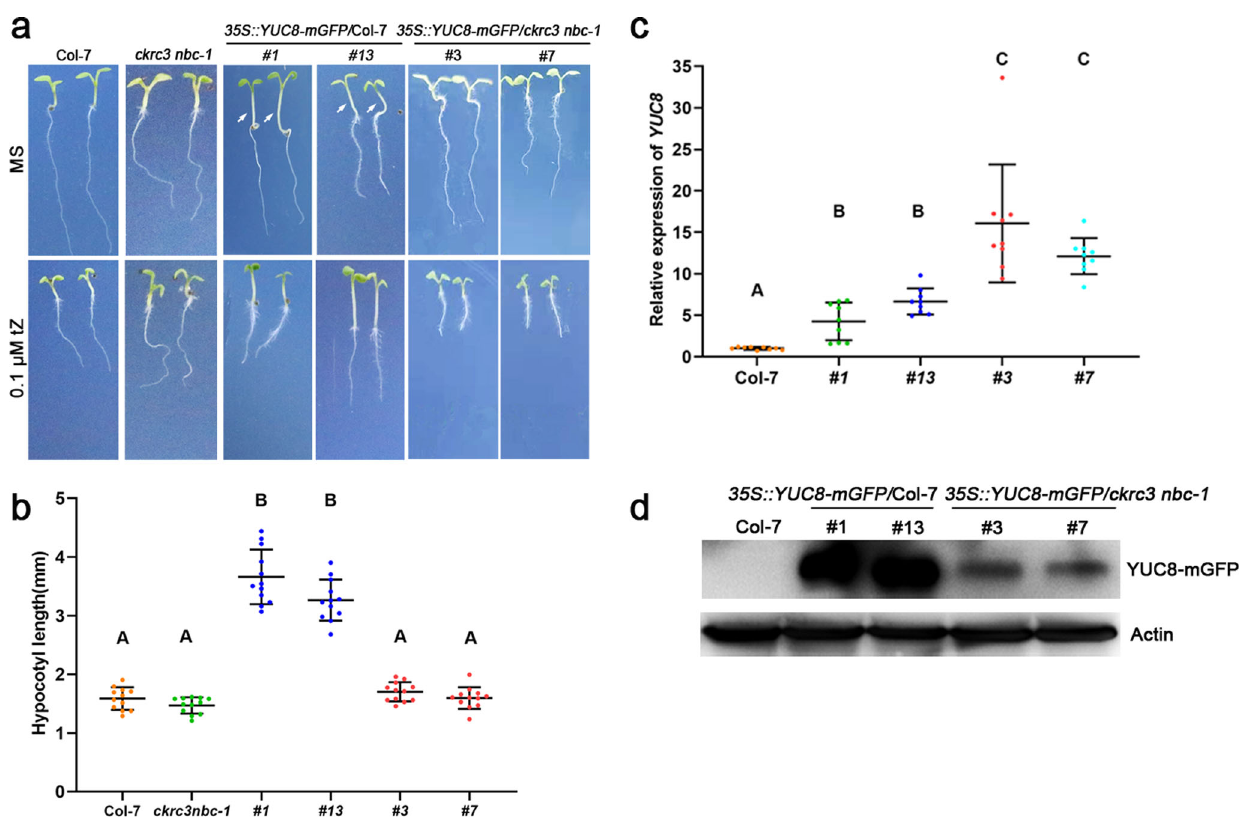
Fig. 3 NatB participates in auxin homeostasis by modulating the stability of YUC8. a Phenotypes of mutants and over-expression lines at 7 DAG on MS media with or without 0.1 μΜ tZ, bar = 5mm. b Hypocotyl length at 7 DAG; n = 12. Data are presented as mean±SD, different capital letters